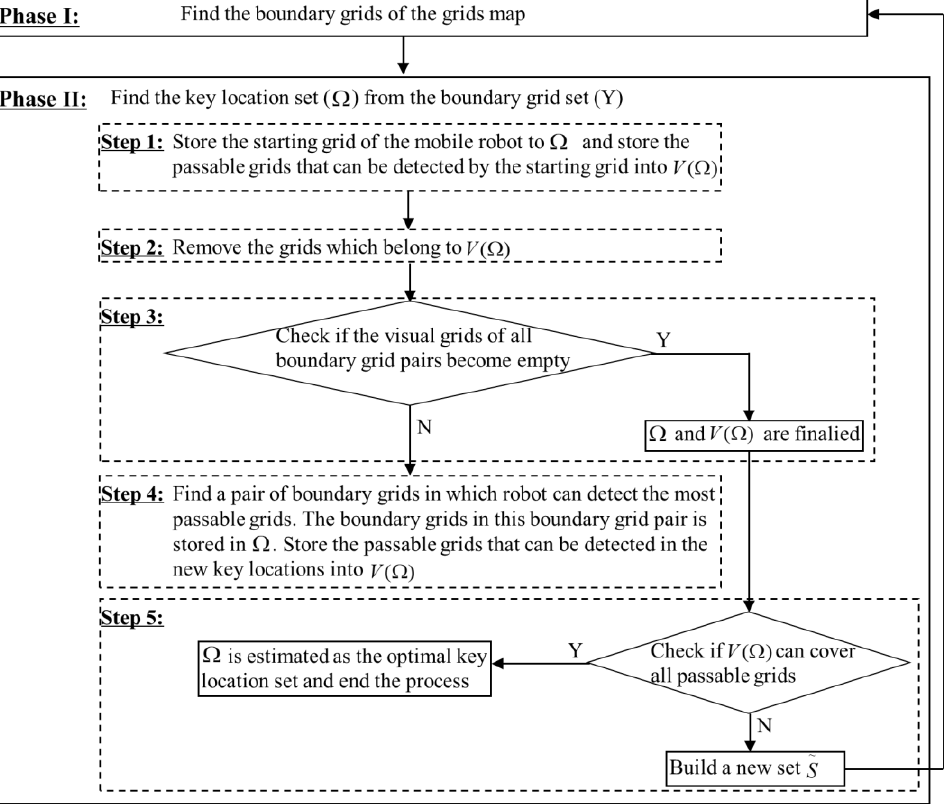
Figure 4. The flow chart of the method to pick out key locations in the grid map.